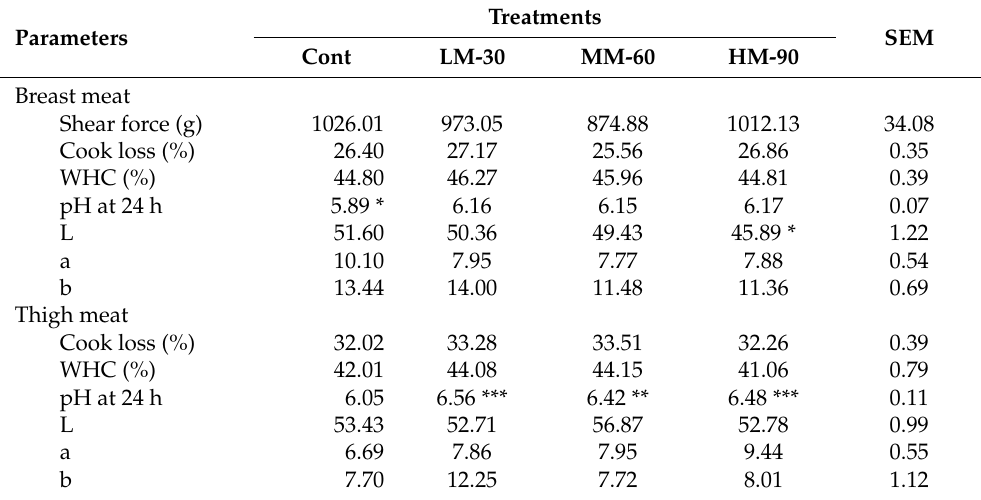
Table 6. Effect of β -mannanase supplementation on meat quality traits in broilers fed low energy diets.